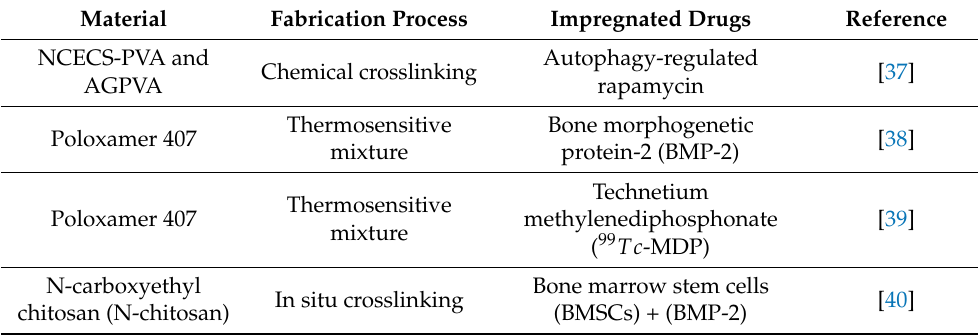
Table 6. Hydrogels within metallic